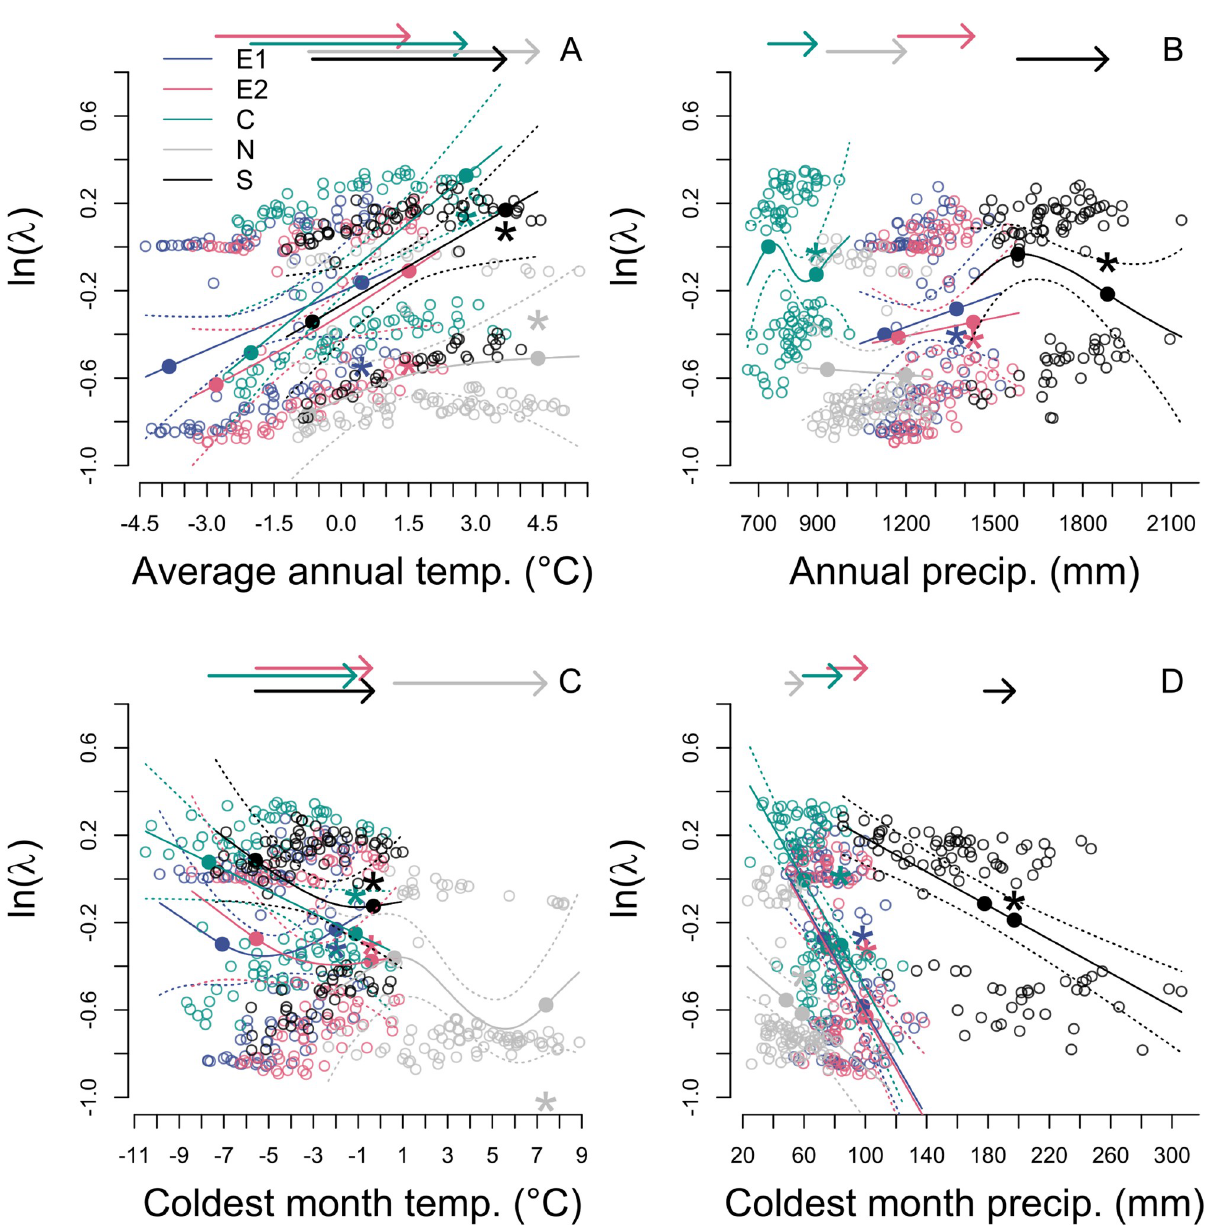
Fig 7. Nonlinear responses of D . alaskana to climate. Response of annual population growth rates ( λ ) to changes in aspects of temperature and precipitation that affect vital rates. Unfilled points represent medians (across bootstrapped regression coefficients) of the annual population growth rates vs. the current and future GCM climate values for each year from 2008 to 2099; curves represent predictions of population-specific GAMs with non-focal climate variables held at their mean values. Arrows on the top of the figures represent the magnitude of climate change at each population; start of the arrow is at the mean climate condition for the current period (2008–2022) and end of the arrow is at the mean climate condition for the future period (2086–2100). Filled points represent population growth rates predicted by the GAM at current and future mean climates, with an asterisk indicating future population growth rate predicted by an LTRE